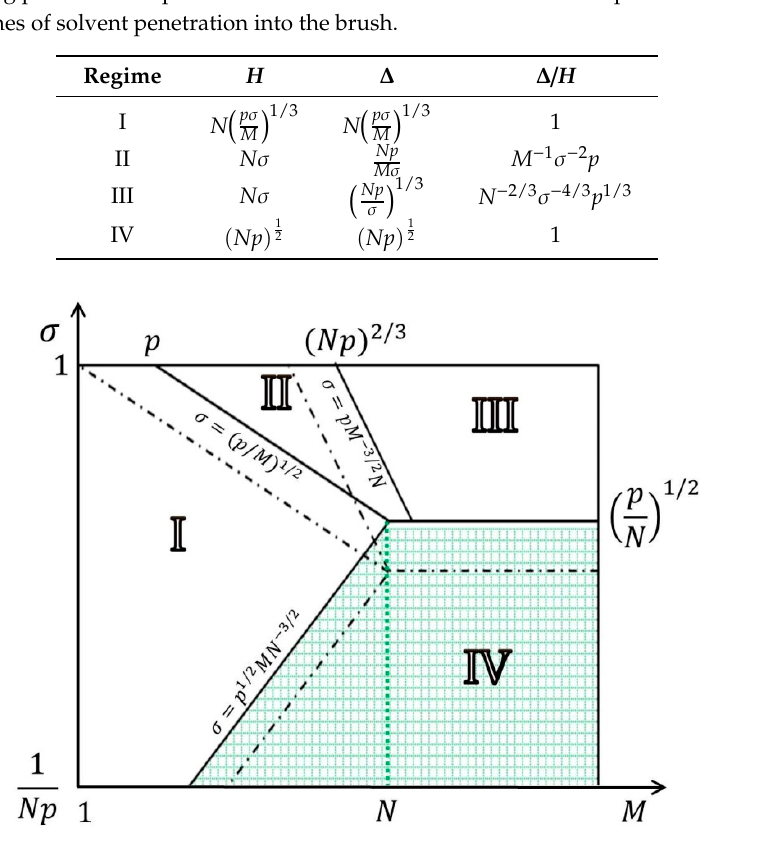
Figure 2. Diagram of states of a planar brush consisting of linear polymer chains with degree of polymerization N >> 1 immersed into melt of chemically identical linear polymer chains with degree of polymerization M . Green area corresponds to loss of the chain stretching, H ∼ ( N p ) 1 / 2 a . Regimes I, II, and III in the diagram correspond to full, partial, and peripheral penetration of solvent molecules into the brush, respectively. The boundaries dividing these regimes are indicated by dashed lines in the case of flexible chains ( p = 1) and solid lines in the case of rigid chains ( p > 1). The graph is plotted in log-log ( σ , M )